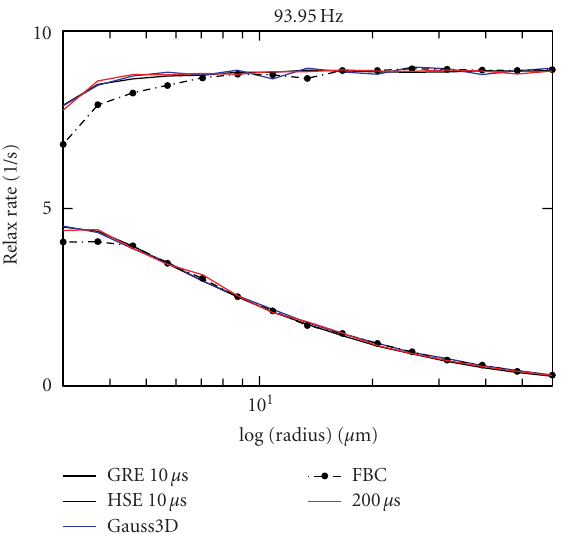
Figure 7: R2/R2 ∗ relaxation rates (in s − 1 ) shown for 5 vessels (cen- tral vessel and 4 next neighbors), respectively, shown for 9 vessels (8 next neighbors) versus data for one single vessel. All neighbor vessels possess the same direction as the central vessel.